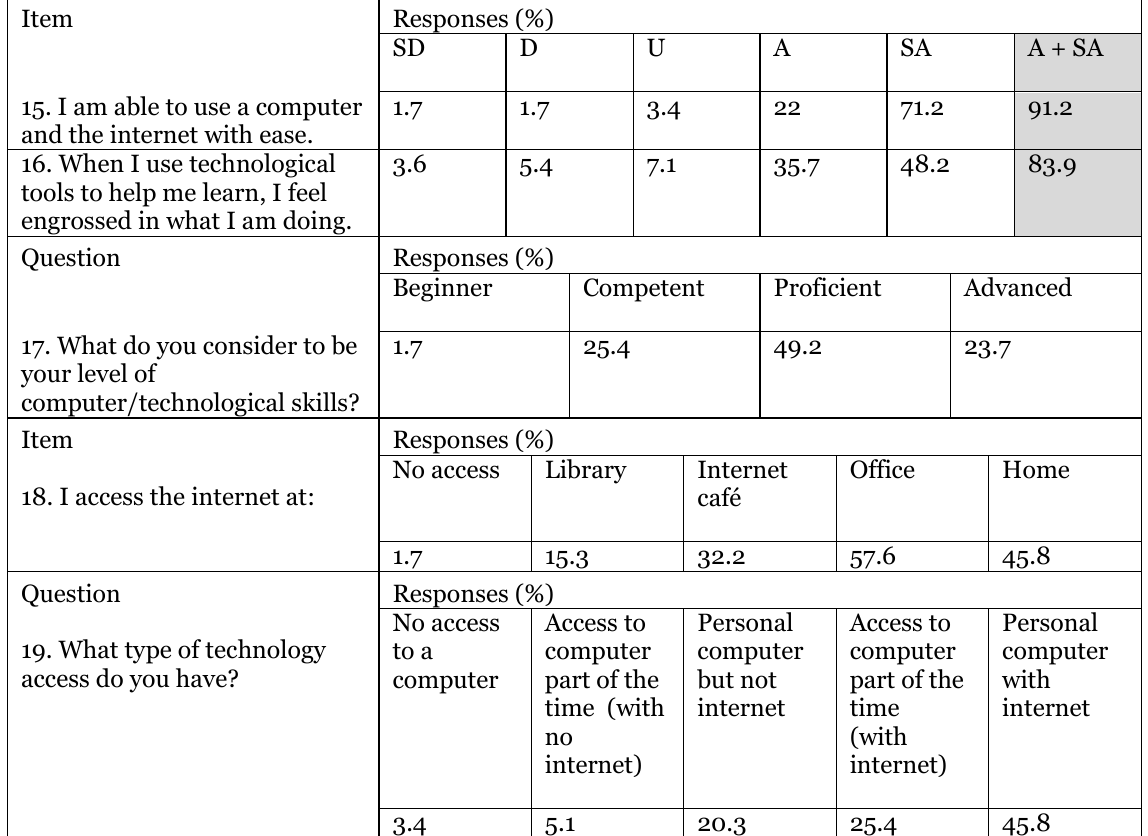
Access to Technology and the Skills Required for Online Learning